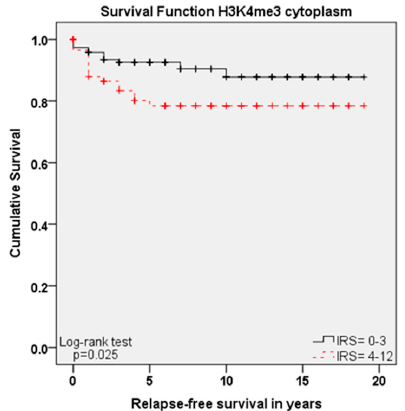
Figure 4. Kaplan–Meier analyses for relapse-free survival: high cytoplasmic H3K4me3 expression (IRS ≥ 4; red) compared to low expression (IRS ≤ 3; black) regarding relapse-free survival ( p = 0.025).